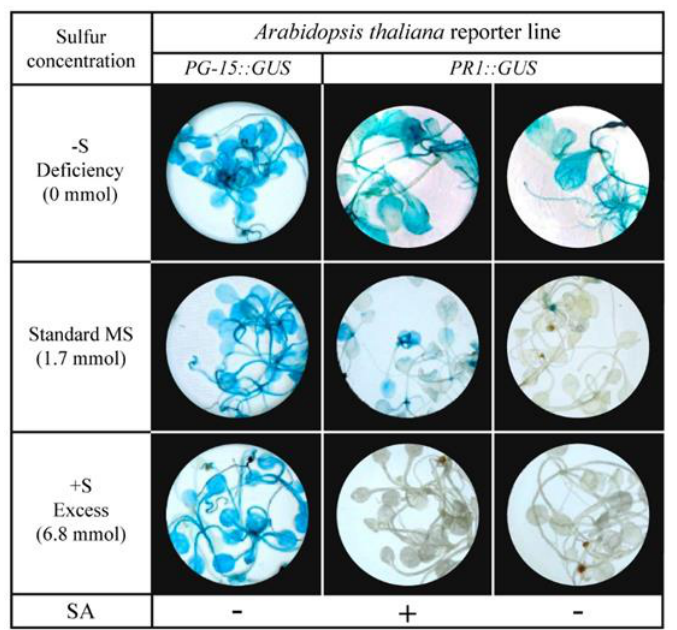
Figure 2. GUS histochemical staining assay of expression in PR1: GUS reporter line induced by deficient (-S) or excessive (+S) sulfur concentrations and an exogenous application of 0.5 mM SA 3-week-old in vitro plants. PG-15:: GUS plants were treated with milliQ water as a positive